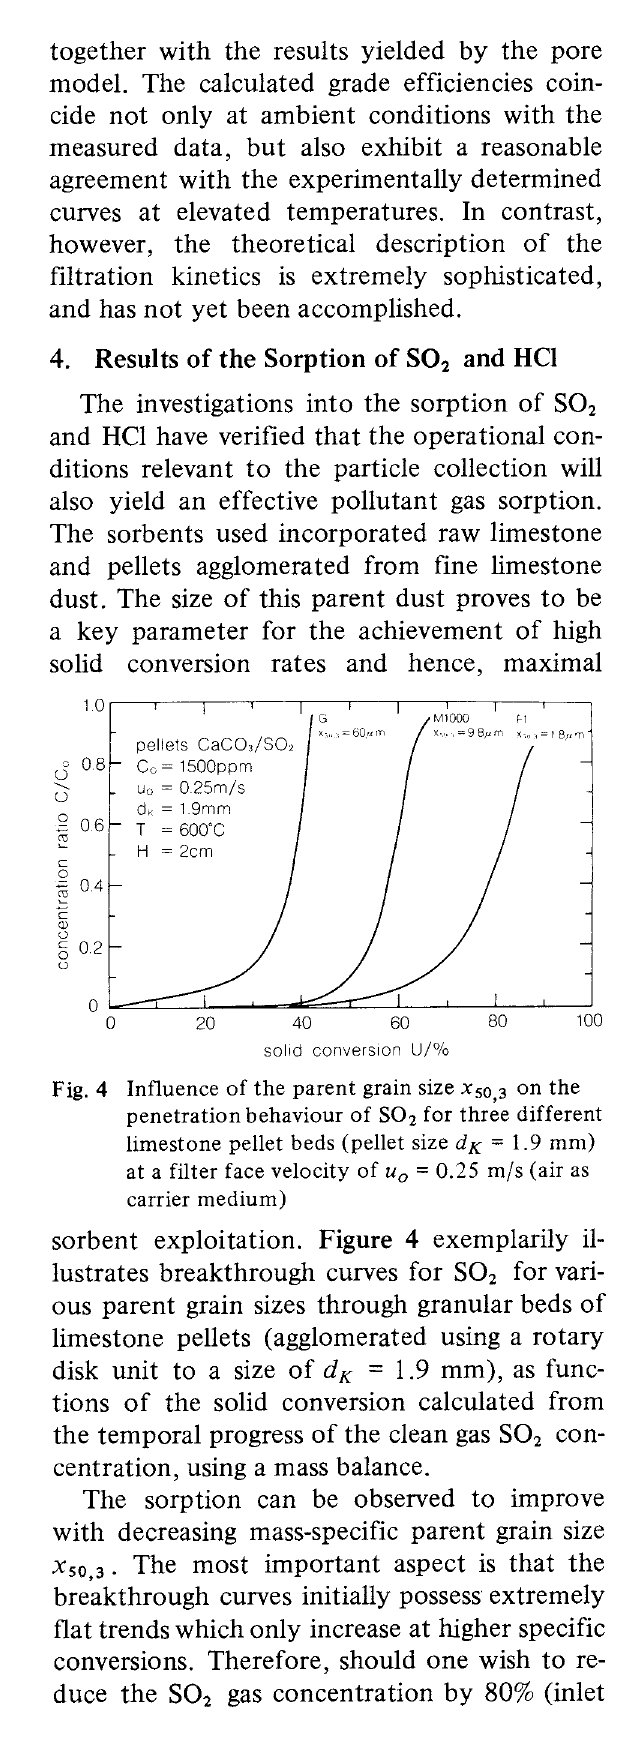
Fig. 3 Comparison between the measured (dots) and the calculated separation efficiency curves (full lines) at room temperature for a limestone bed with a grain size of dK = 0.29 mm and a filter face velocity of u = 0.1 mjs 0